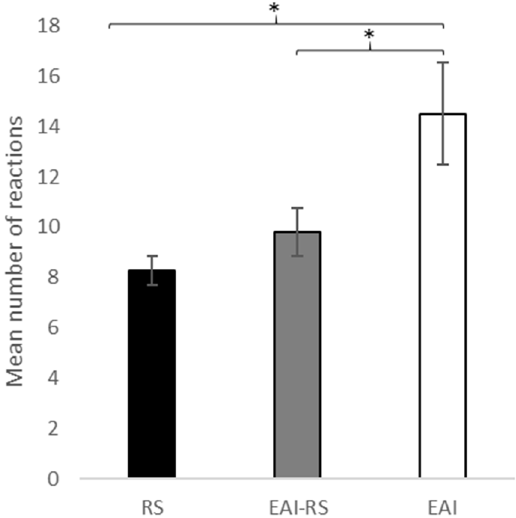
Figure 1. Mean number of total number of reactions (tremor = 1/no tremor = 0) to the tactile reactivity test using von Frey filaments. The data represent the sum of all responses (4 filaments tested on both sides on 3 areas of the body). RS = riding school lessons horses (N = 14), EAI = assisted-intervention horses (N = 6), EAI-RS = horses with mixed activity (N = 40). Kruskal-Wallis and Mann-Whitney U tests, * p < 0.05.